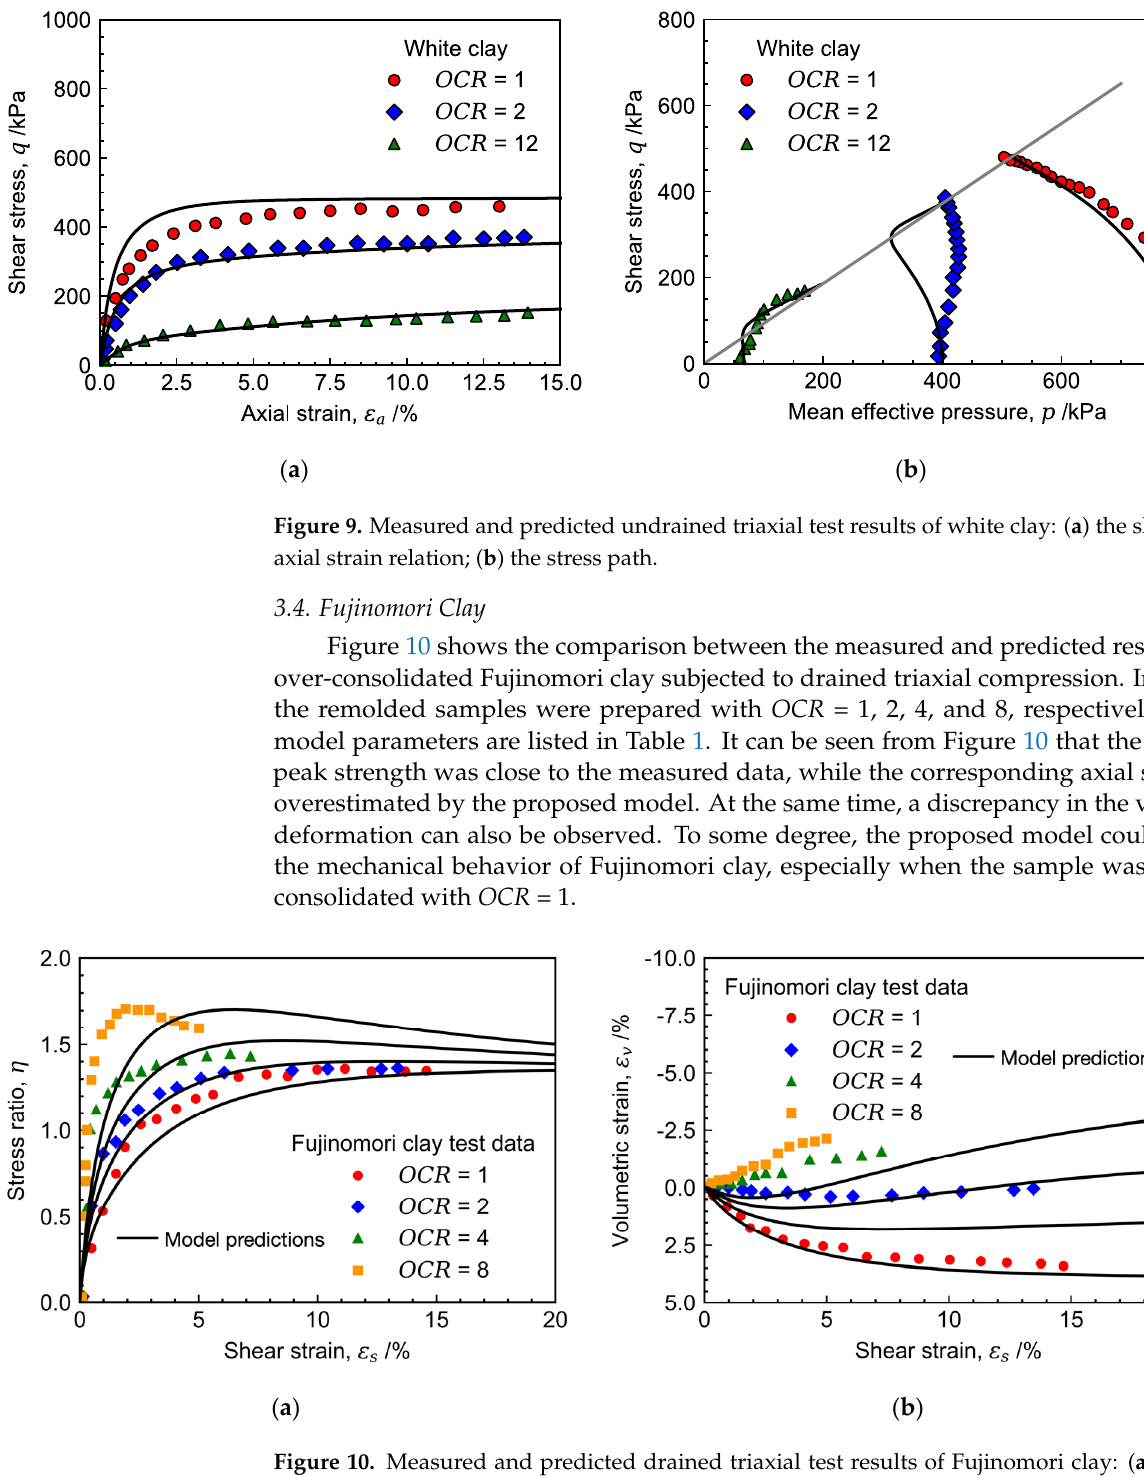
Figure 9. Measured and predicted undrained triaxial test results of white clay: ( a ) the shear stress– axial strain relation; ( b ) the stress path.